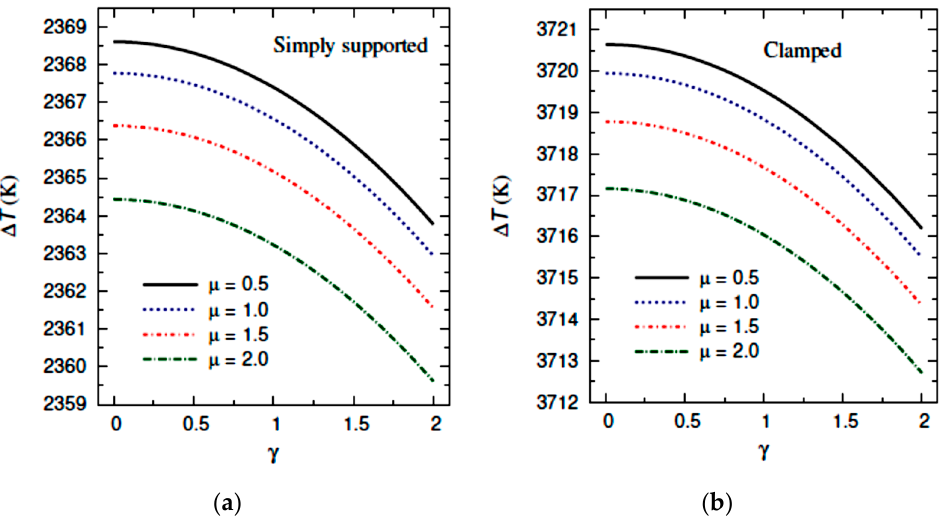
Figure 10. Effects of the nonlocal coefficient µ and strain gradient coefficient γ on the critical buckling temperature ∆ T cr of ( a ) simply supported and ( b ) clamped SGP annular plates ( R o / h = 3, R i / R o = 0.3, κ = 0, E ζ = 5 V/m, ∆ C = 1%, e 0 = 10, w g = 0.1%, J 1 = 10 3 , J 2 = 10 2